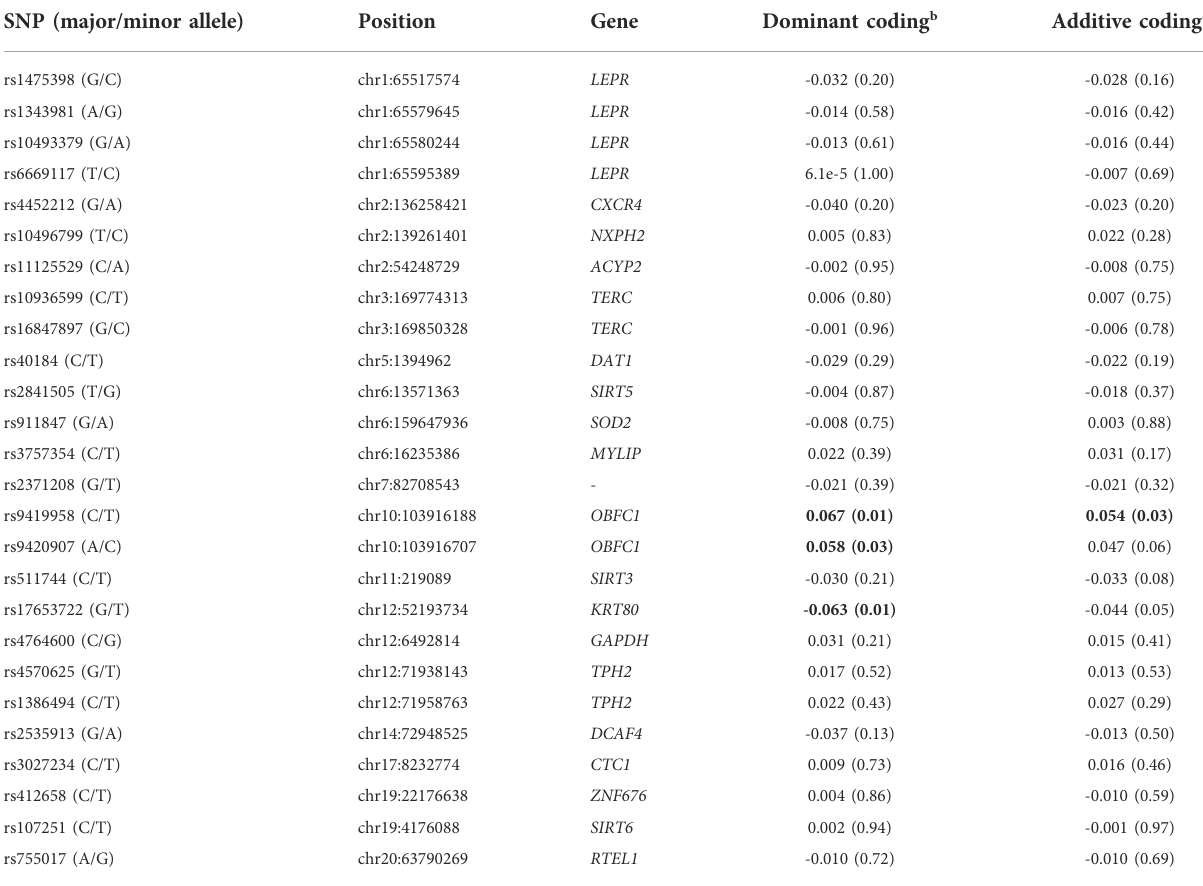
TABLE 2 Association (nominal p -value) between SNPs and newborn telomere length a . SNP (major/minor